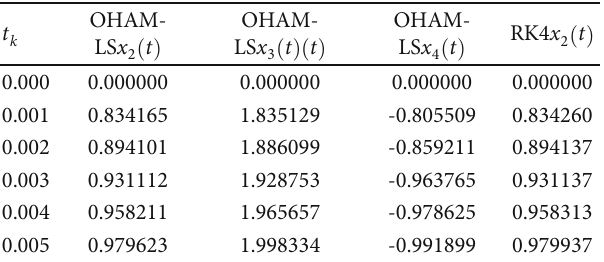
Table 7: Comparisons and absolute error between OHAM-LS and RK4, α = 1 .